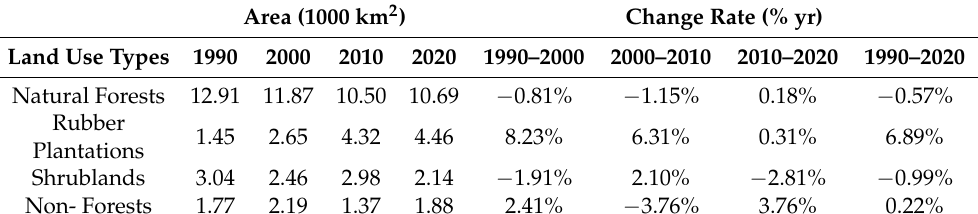
Table 3. Land use/land cover changes and change rate of Xishuangbanna during 1990–2020.